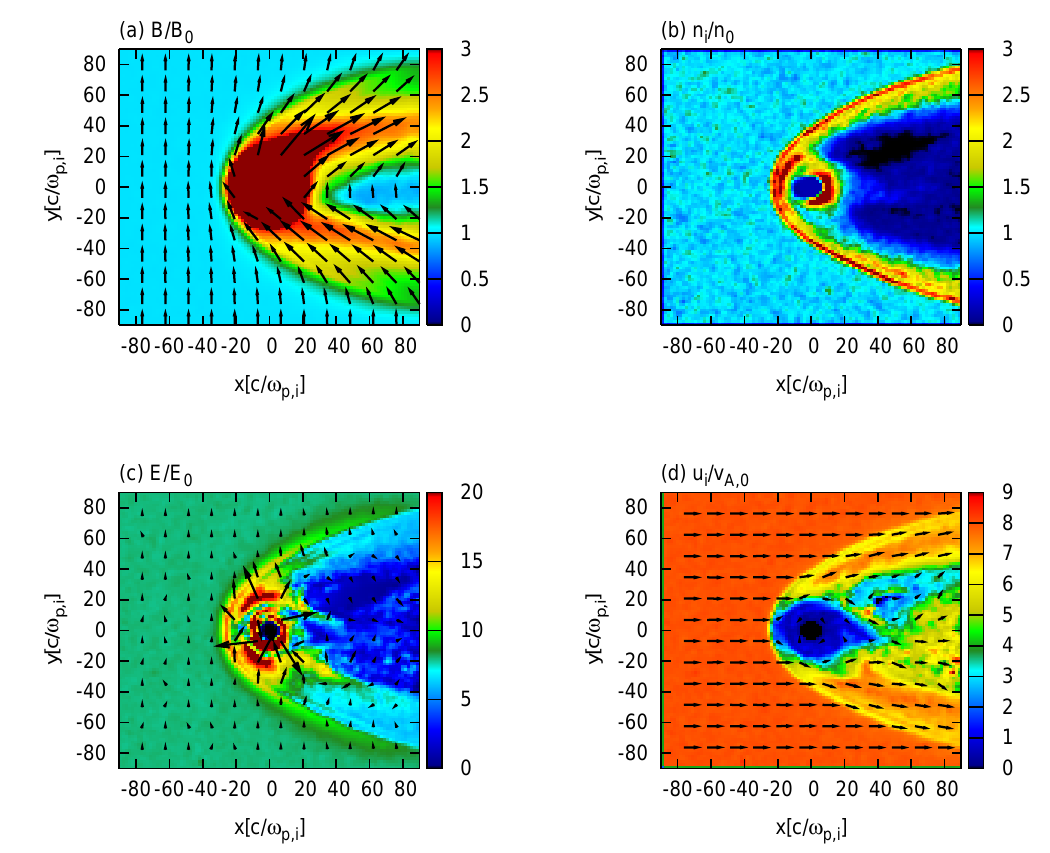
Fig. 2. Perpendicular orientation of B SW and M – Cut through the (x,y) plane of the simulation box. The figure displays (a) the magnetic field, (b) the mean plasma density, (c) the electric field and (d) the mean ion velocity. All quantities are normalized to upstream values of the undisturbed solar wind: The plasma density and the magnetic field are given with respect to the upstream plasma density n 0 and the magnetic field strength B SW , respectively, whereas the velocity is normalized to the Alfv´en velocity v A, 0 in the undisturbed plasma flow. The electric field is given in units of E 0 = v A, 0 B SW . The interplanetary magnetic field clearly drapes around the obstacle. Besides, a cavity with significantly reduced plasma density is formed in the downstream region. A boundary layer denoting a sudden increase of plasma density separates the dipol-dominated region from the ambient solar wind flow. These structures indicate the formation of some kind of sub-magnetosphere around the